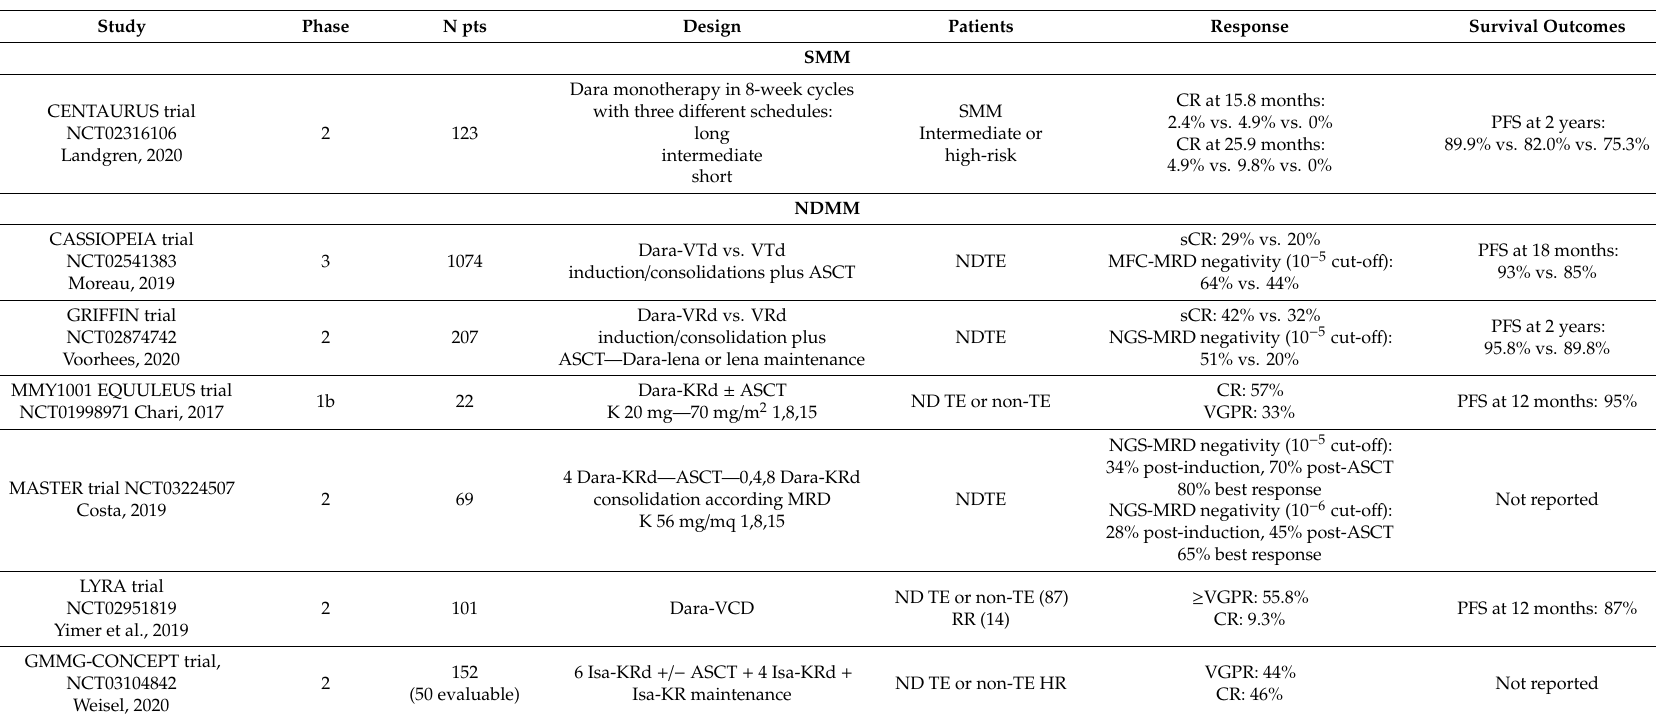
Table 1. Results of selected clinical trials with Daratumumab and Isatuximab for smoldering and newly diagnosed multiple